Question: Sum up the contents of this chart in one sentence.
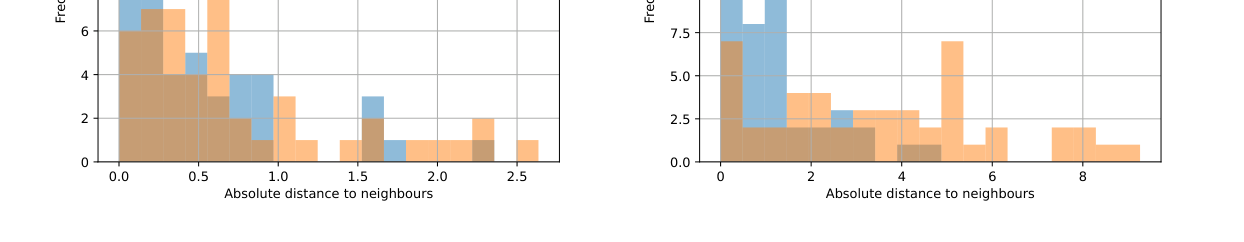
Answer: We investigate the difference between the loss of our unlearnt model (with GA and SGA) and a retrain-from-scratch proxy (proxy ‘data neighbours’ computed as shown in Appendix C). We do this for every sample in the forget set! Naturally, higher indistinguishability means much smaller distances (i.e., between 0 and 0.5 in our experiments on unseen data). The two figures show the loss distances of the forget set for the 125M and 1.3B checkpoints of GPT-Neo, aggregated across several forget sets/ unlearning runs.